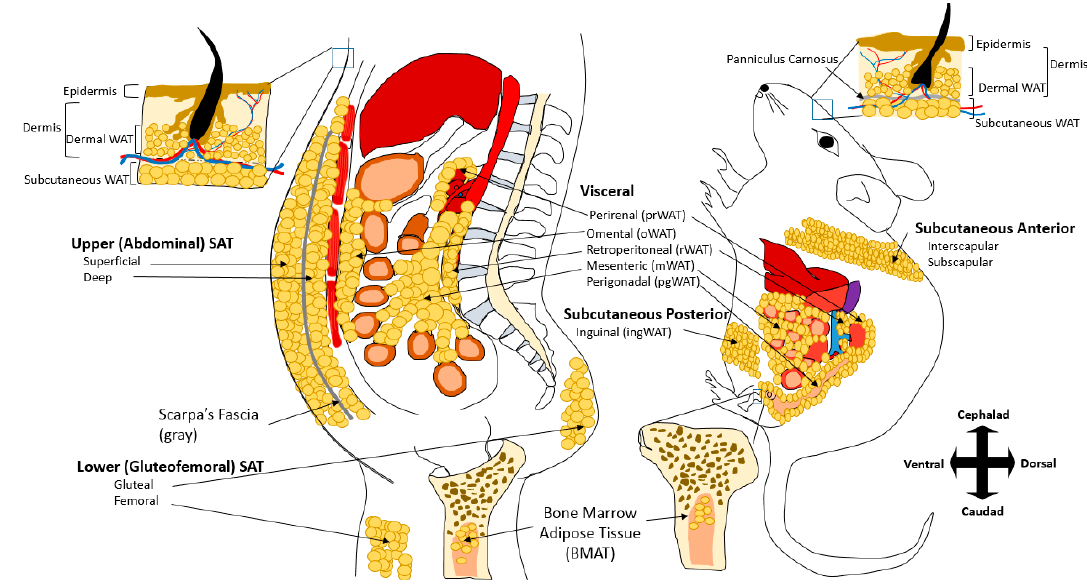
Figure 1. Comparison between Human and Rodent Adipose Tissues. White Adipose Tissues (WAT) are mostly visceral adipose tissue (VAT) and subcutaneous adipose tissue (SAT). Major visceral depots common in both humans and rodents include epicardial/pericardial (not shown), perirenal (prWAT), retroperitoneal (rWAT), and mesenteric WAT (mWAT). While humans have large omental (oWAT) fat, mice have large perigonadal (pgWAT) fat. SAT in humans can be divided into upper (abdominal) and lower (gluteofemoral). Abdominal fat in human can be further divided into superficial and deep, which are separated anatomically by Scarpa’s Fascia. In mice, SAT is divided into anterior and posterior. Dermal WAT (dWAT) is another fat depot that exists in both humans and mice. dWAT is located in the dermis and above the SAT (note: this separation is visible by the presence of striated muscular layer known as panniculus carnosus only found in mice). Bone marrow adipose tissue (BMAT or MAT) is also another adipose depot common in both species. Cephalad and caudad are also referred to as anterior and posterior in mice, respectively.